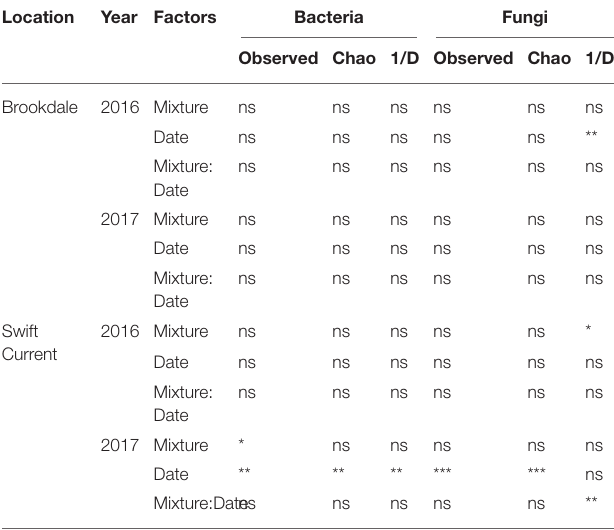
TABLE 3 | ANOVA results of the effect of cropping mixtures (monoculture, three, six, and nine spp.) and date of sampling (mid or late growing season) on soil properties at the Swift Current and Brookdale research sites in 2016 and 2017. Location Year Factors